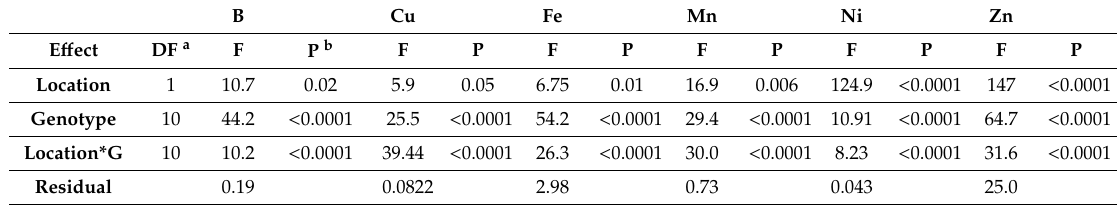
Table 1. Analysis of variance (F and P values) of the e ff ects of location, genotype (G) (cotton chromosome substitution (CS) lines, parent TM-1, and commercial cultivar AM UA48), and their interactions